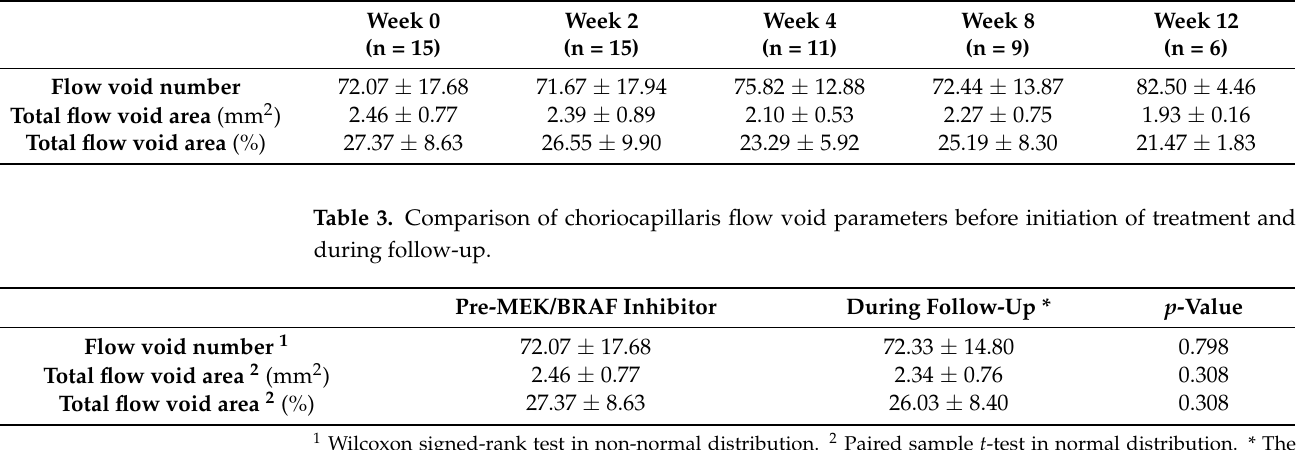
Table 2. Choriocapillaris flow void parameters at each control.